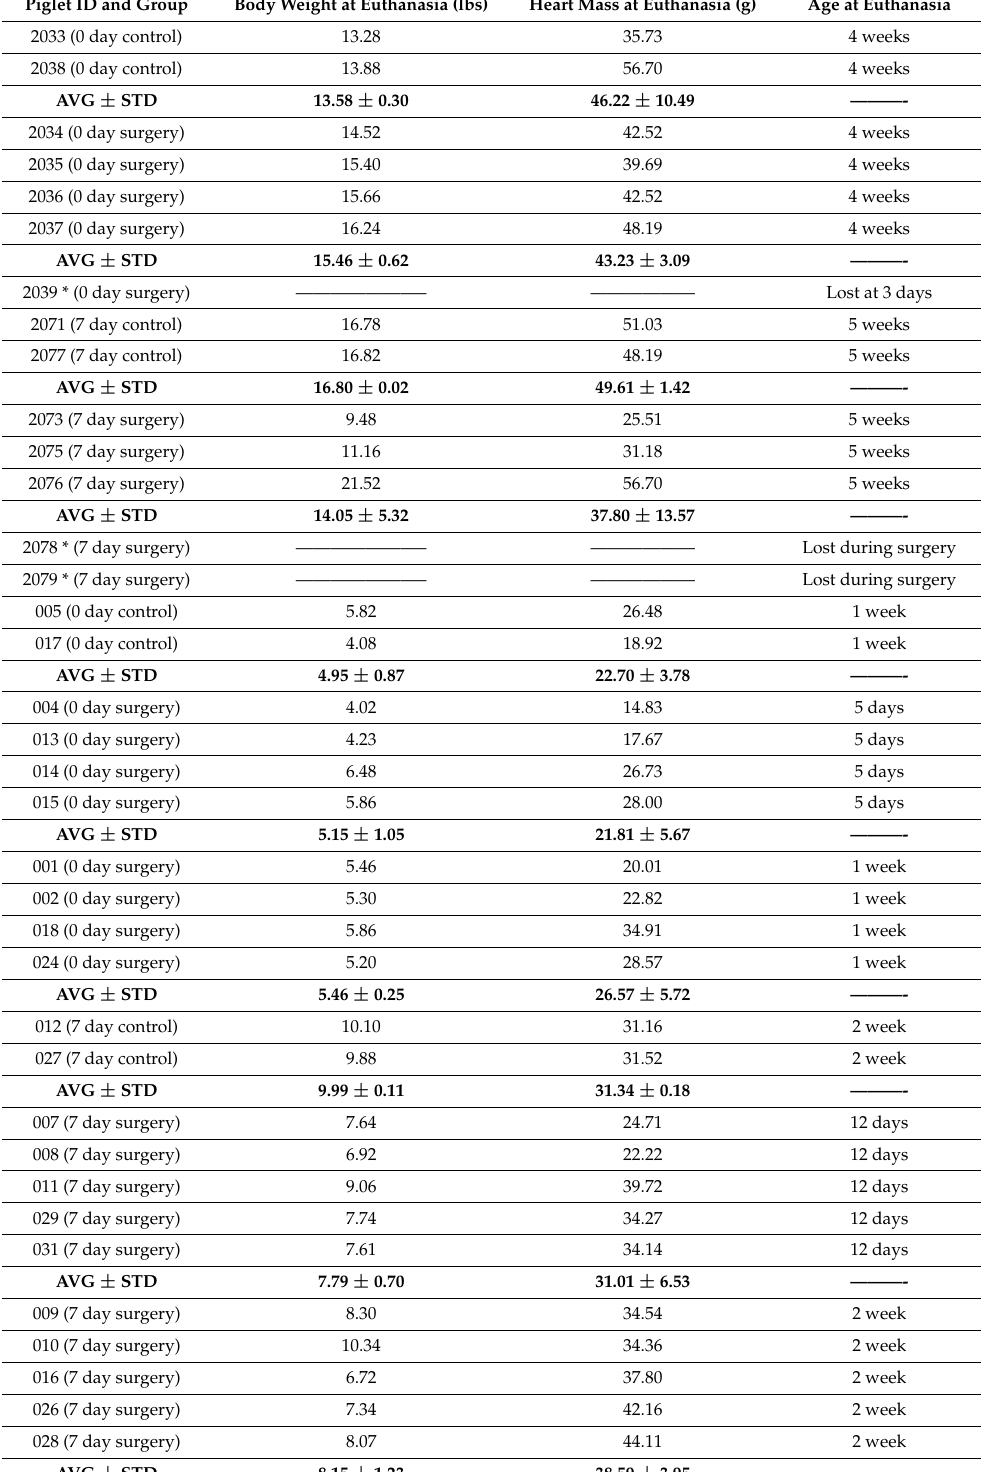
Table 3. Body weight, weight of the heart, and age of piglets at euthanasia. * denotes the loss of animal during the surgery or experiment. Piglet ID and